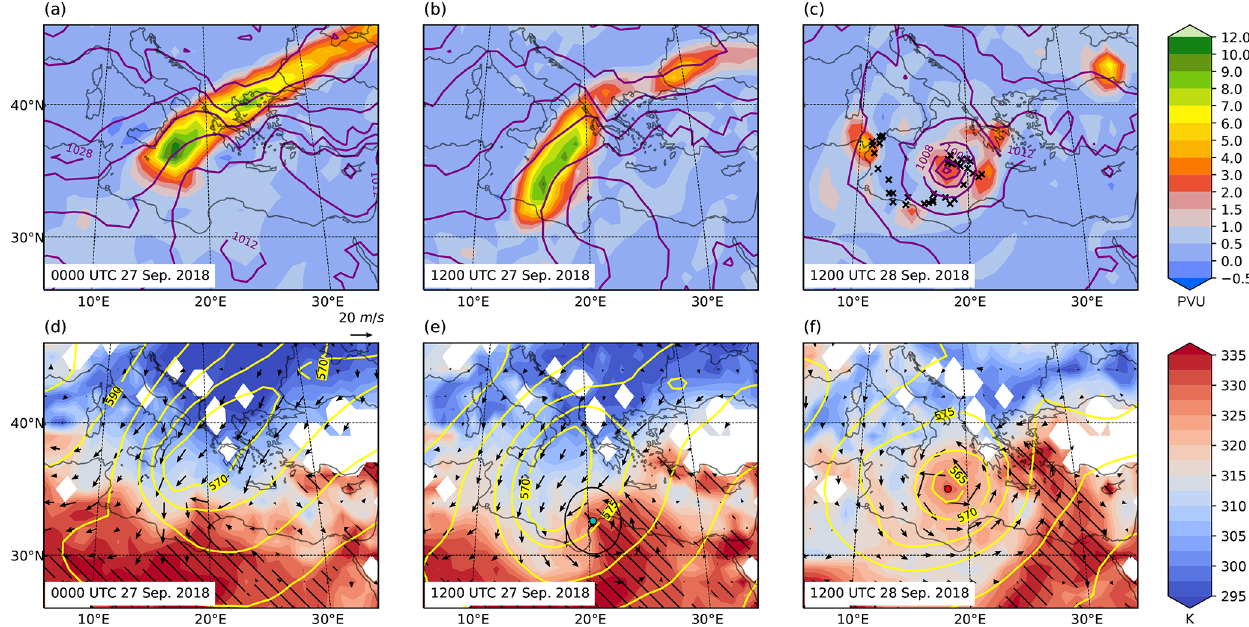
Figure 2. Synoptic situation over the Mediterranean after the formation of the PV streamer at (a, d) 00:00UTC 27 September 2018, (b, e) 12:00UTC 27 September 2018, and (c, f) 12:00UTC 28 September 2018. (a–c) PV at 325K (shaded, in PVU; this level corresponds approximately to the 300–350hPa pressure levels in this region), sea level pressure (purple contours, every 4hPa); (d–f) equivalent potential temperature ( θ e , shaded, in K; white areas are missing values due to orography) and wind vectors at 900hPa (black arrows, reference vector above panel d ), and geopotential height at 500hPa (yellow contours, every 5gpdm). The hatched areas in (d–f) show regions where θ e at 900hPa is anomalously high (at least 1 standard deviation larger than climatology) with respect to the Sep–Oct ERA-Interim climatology for the period 1979–2017. In (e) , the black circle denotes the circle with radius 250km from which forward trajectories were started for air parcels with θ e > 322 . 5K, and black crosses in (c) show the position of these air parcels 24h later if they reached above the 322.5K isentropic level.